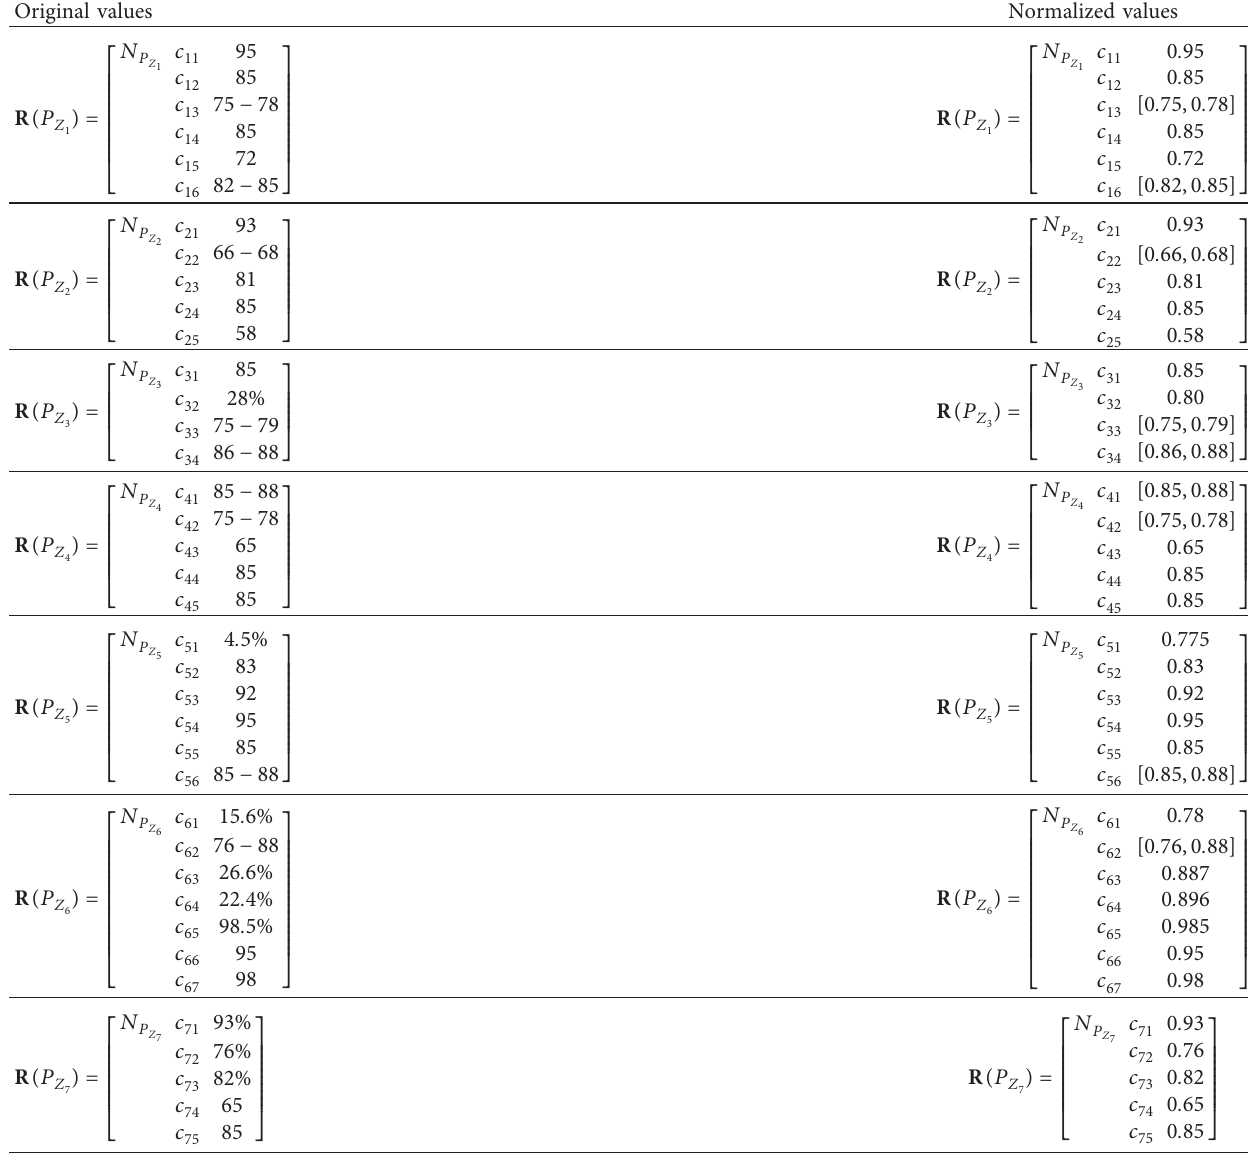
Table 3: Original and normalized values of HRMPA indices.